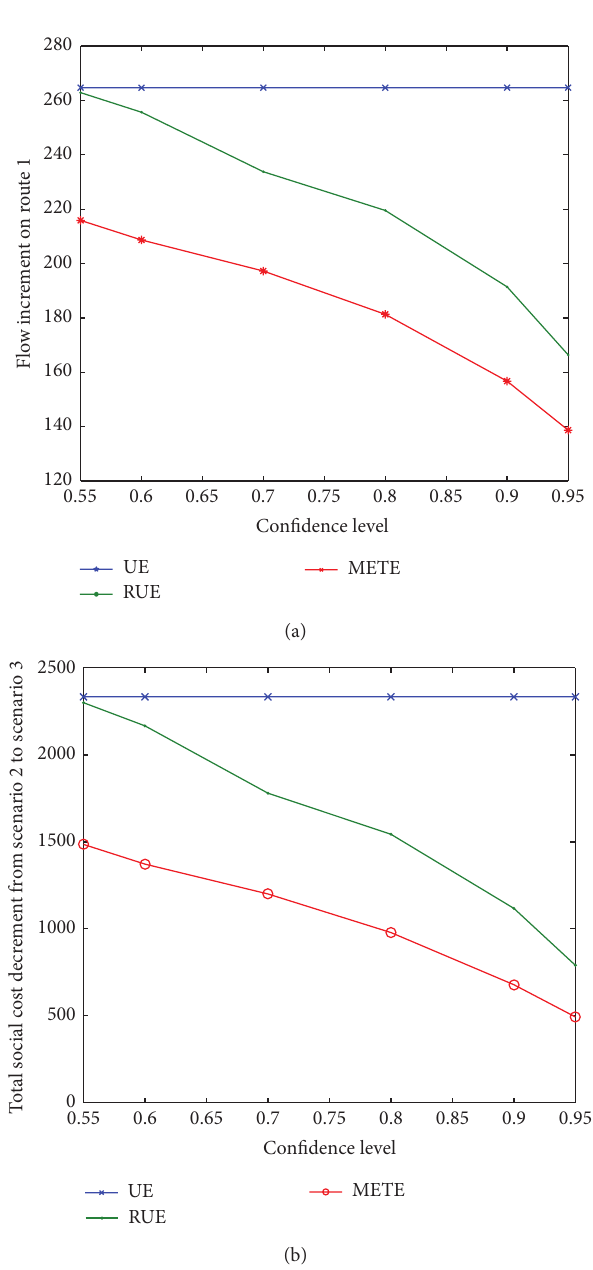
Figure 4: Route 1 flow increment and TSC decrement from scenario 2 to scenario